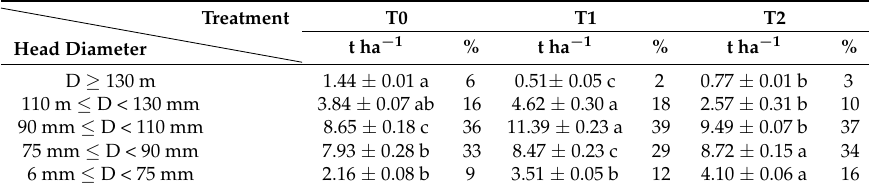
Table 4. Yield distribution (t ha − 1 ) and its percentage classified by diameter according to the cutting type used for the artichoke vegetative propagation.